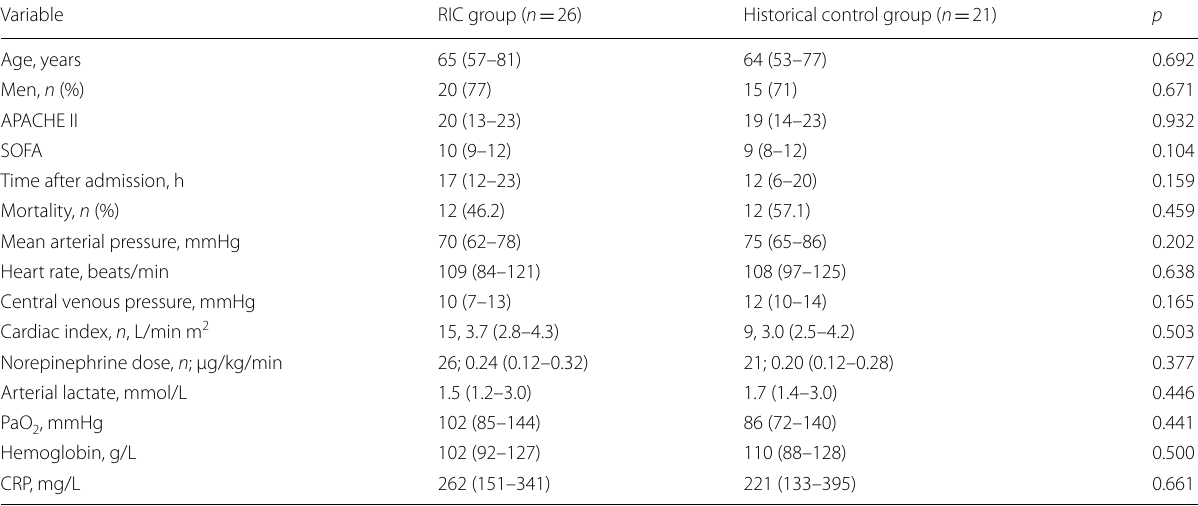
Data are presented as the median (interquartile range [IQR]) APACHE Acute Physiology and Chronic Health Evaluation, SOFA Sequential Organ Failure Assessment, PaO 2 partial pressure of oxygen, CRP C-reactive protein